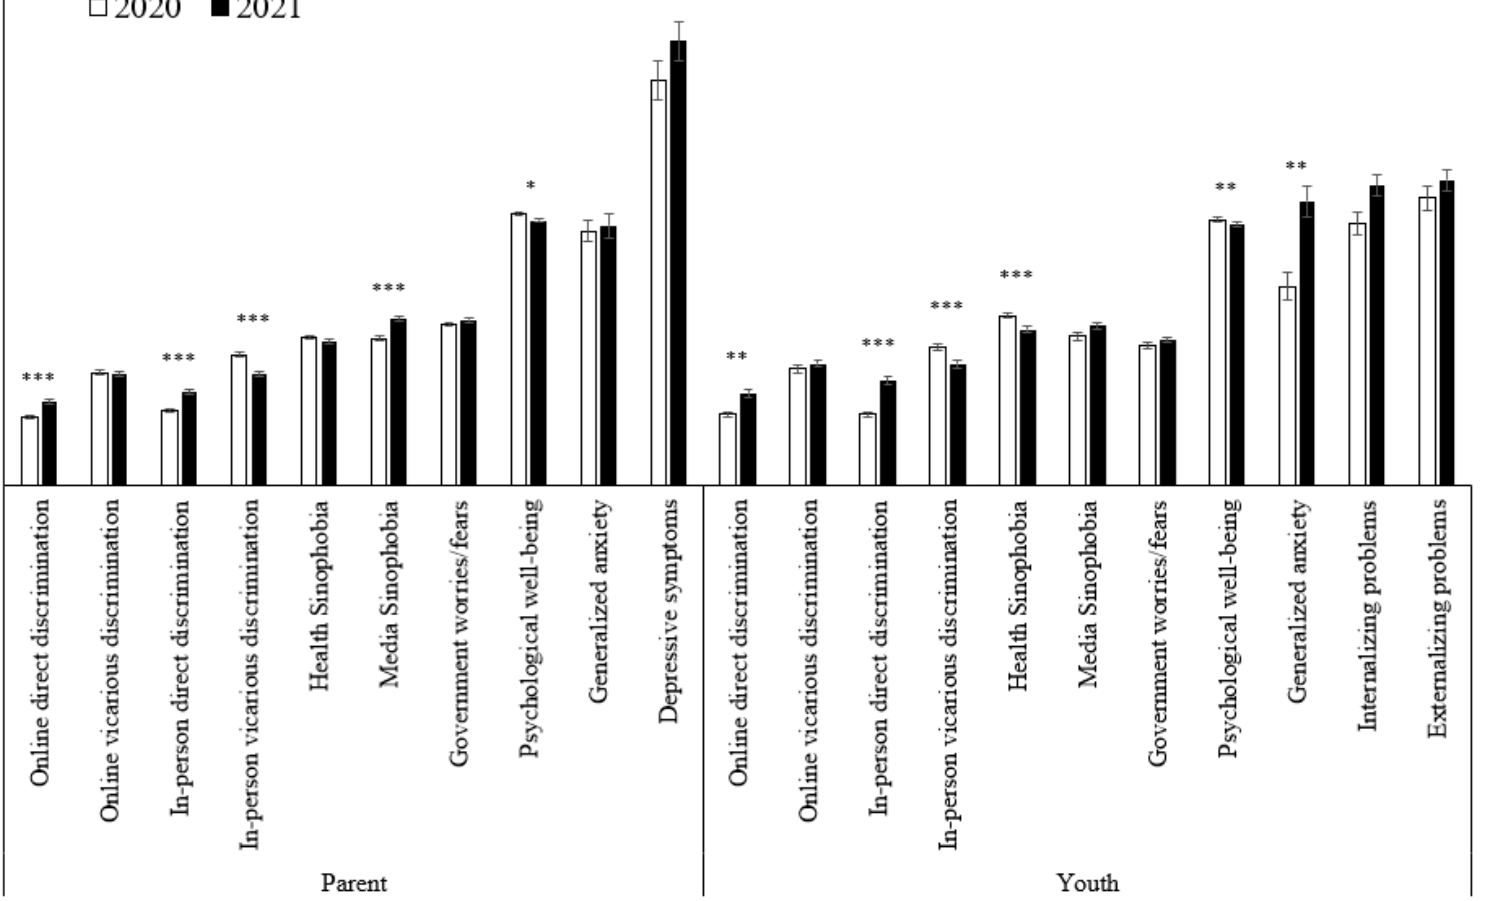
Figure 1. Comparisons of parents’ and youths’ discrimination, Sinophobia perceptions, government-related worries, and mental health indices between 2020 and 2021 from ANCOVA models. Note. Means presented in this figure are observed values and the mean differences between observed values may be different from estimated marginal mean differences that controlled for covariates in Table 3. The statistical test of the mean differences is presented based on the ANCOVA models. * p < 0.05, ** p < 0.01, *** p < 0.001